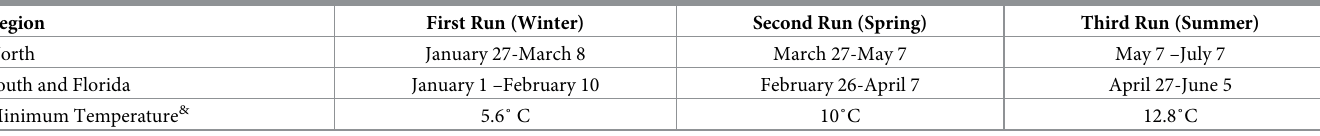
Table 2. Louisiana Amphibian Monitoring Program (LAMP) survey windows and minimum